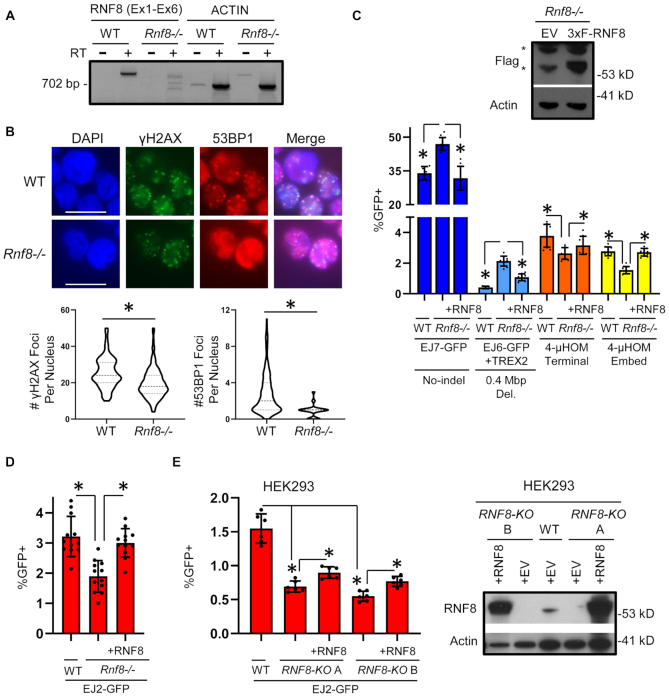
RNF8 promotes ALT-EJ. (A) RNA analysis of an Rnf8-/- mESC line generated using Cas9 and sgRNAs targeting Rnf8. Shown are RT-PCR amplification products for a region of the RNF8 mRNA from exons 1–6 (Ex1–Ex6), and Actin control, for RNA from WT and Rnf8-/- mESCs, treated with and without reverse transcriptase (RT). (B) The Rnf8-/- mESC line shows a defect in 53BP1 foci formation. Shown are representative fluorescent images of WT and Rnf8-/- mESCs treated with 6 Gy and recovered for 4 h, stained with DAPI and antibodies for γH2AX and 53BP1. Scale bar = 20 μm. Also shown are violin plots depicting the number of γH2AX foci per nucleus (left) and 53BP1 foci per nucleus (right) in WT and Rnf8-/- mESC. N = 120. (*) P < 0.001 for WT versus Rnf8-/- measuring γH2AX or 53BP1 foci using the Mann–Whitney test. (C) RNF8 promotes ALT-EJ, and inhibits EJ without indels (i.e. C-NHEJ). Shown are the GFP+ frequencies for several chromosomal reporter assays (EJ7-GFP, EJ6-GFP+TREX2, 4-μHOM Terminal and 4-μHOM Embed) in WT mESCs, Rnf8-/- mESCs and Rnf8-/- mESCs transfected with a 3×Flag-tagged RNF8 expression vector (3×F-RNF8). WT EJ7-GFP and EJ6-GFP+TREX2 values are from Figure 1C and shown here for comparison. As with all mESC experiments in this study, the reporters are integrated into chromosome 17 at the Pim1 locus. Error bars represent SD. N ≥ 6. (*) P ≤ 0.038 using unpaired multiple t-tests with the Holm–Sidak correction. Also shown is an immunoblot staining for Flag, and Actin control, in Rnf8-/- mESCs transfected with and without 3×F-RNF8. (*) Non-specific bands. (D) RNF8 promotes ALT-EJ in mESCs, as measured by the EJ2-GFP reporter. Shown are GFP+ frequencies for EJ2-GFP in WT and Rnf8-/- mESCs with and without complementation vector. N = 12. Error bars represent SD. (*) P ≤ 0.001 for unpaired multiple t-tests with the Holm–Sidak correction. (E) RNF8 promotes ALT-EJ in HEK293 cells, as measured by the EJ2-GFP reporter. Two independent RNF8 knockout (RNF8-KO) cell lines (RNF8-KO clones A and B) were generated in an HEK293 cell line with the EJ2-GFP reporter. Shown are GFP+ frequencies for the EJ2-GFP assay for these two cell lines with and without an RNF8 expression vector, as well as for the HEK293 WT cell line. N = 6. Error bars represent SD. (*) P ≤ 0.001766 for unpaired multiple t-tests with the Holm–Sidak correction. Also shown is an immunoblot analysis for RNF8, and Actin control, for the two RNF8-KO HEK293 cell lines transfected with RNF8, or only control EV, along with HEK293 WT cells transfected with EV.